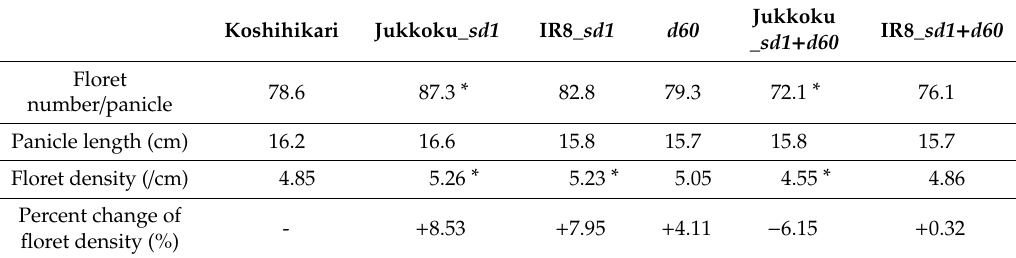
Figure 6. Effect of semidwarf and double dwarf genes to floret density. The floret density was larger in all lines carrying one semidwarf gene than that of Koshihikari. Table 5. Effect of semidwarf and double dwarf genes to panicle.